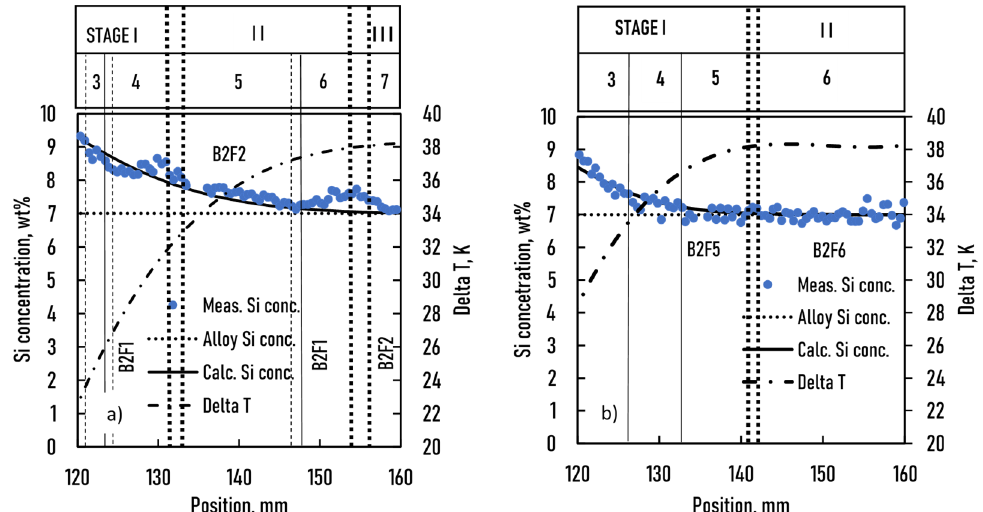
Figure 8. Calculated Si concentration from the corrected measured amount of eutectic, the calculated concentration by diffusion, and the calculated temperature range of solidification (TL–TE) vs. position in the samples.position in the samples ( a ): samples B2F1 and BF2, ( b ): samples B2F5 and B2F6 .